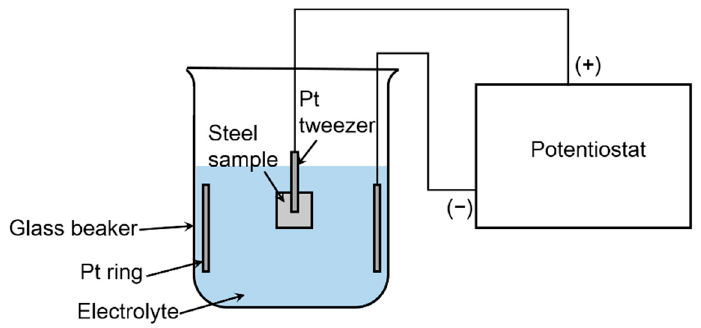
Figure 2. The schematic diagram of the electrolytic extraction equipment.